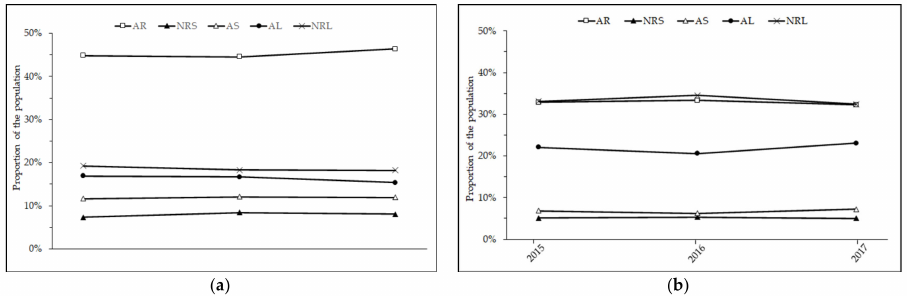
Figure 2. Trends in adherence to NSF sleep duration recommendations from 2015 to 2017: ( a ) on weekdays; ( b ) at weekends. AR—appropriate recommended duration; AS—appropriate but short; AL—appropriate but long; NRS—not recommended: too short; NRL—not recommended: too